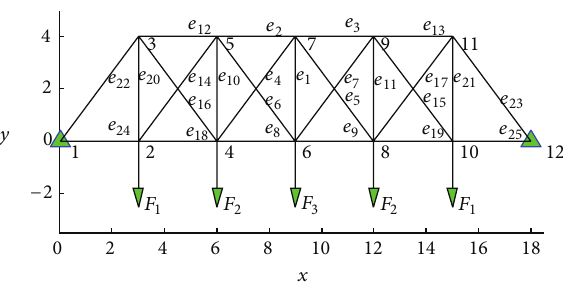
Figure 4: 25-bar truss.